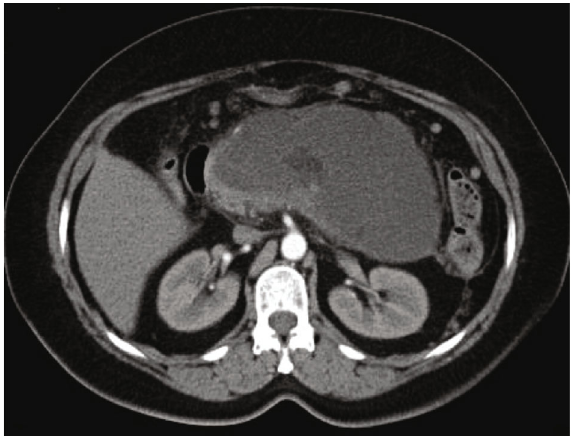
Figure 2: CECT of the abdomen in a patient with WOPN at week 8 of acute necrotizing pancreatitis.